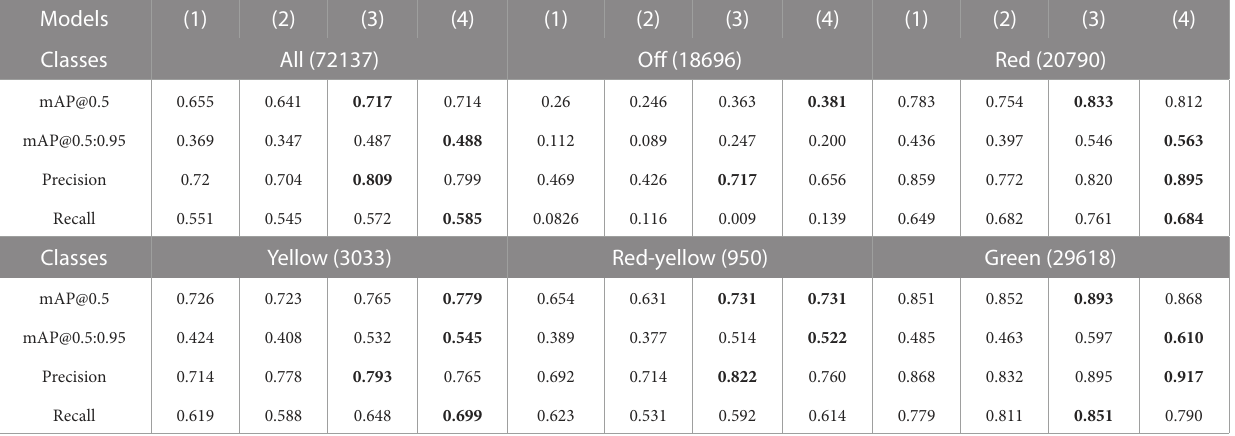
TABLE2 Class-basedcomparisonofthemodelsforthesinge-labeltask.